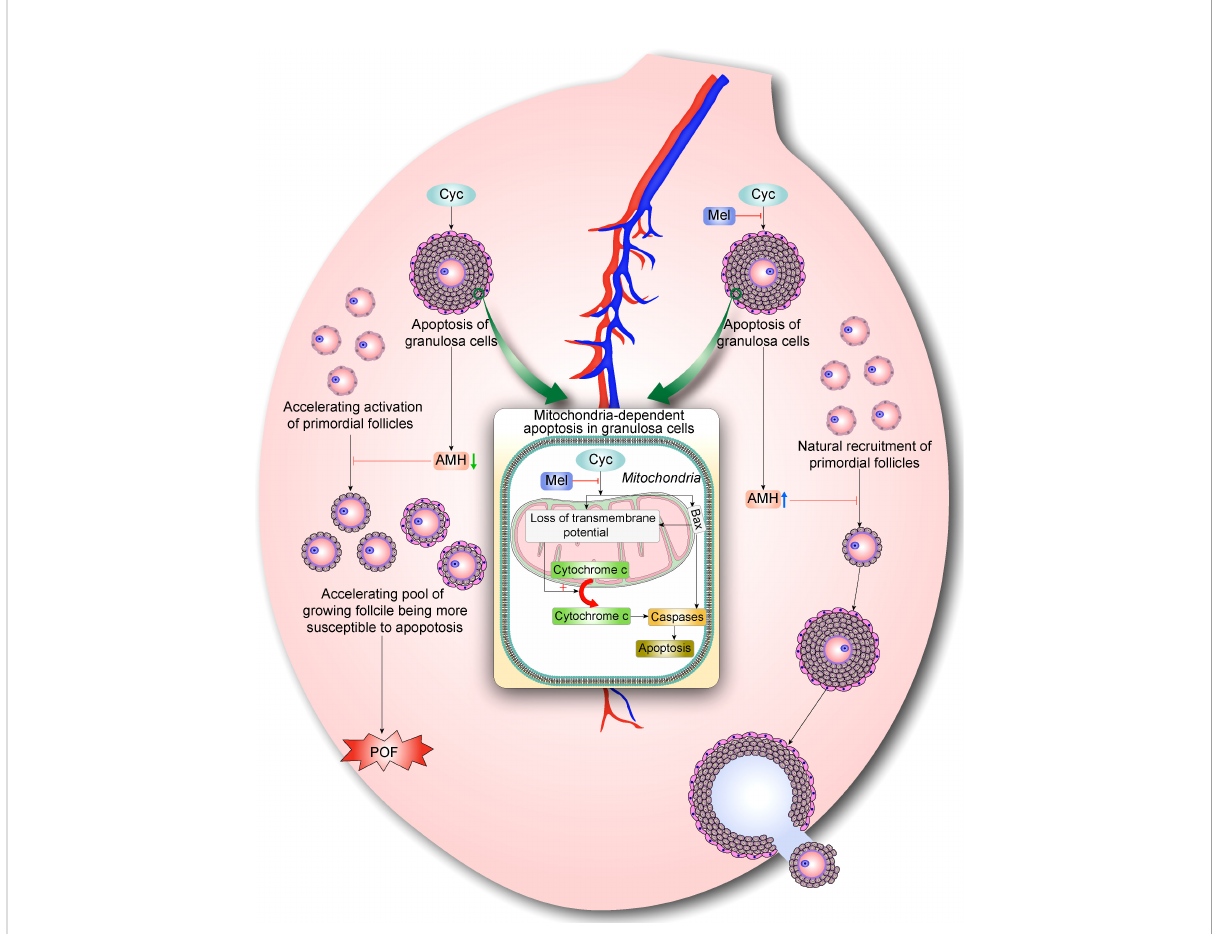
FIGURE 6 Mel prevents Cyc-induced over-activation of primordial follicles through inhibiting ovarian granulosa cell apoptosis and maintaining AMH expression. During normal follicle development, very few primordial follicles are selected and activated, whereas the vast majority of primordial follicles are maintained in a dormant state. AMH is mainly produced by granulosa cells in secondary follicles and early antral follicles. AMH can inhibit the activation of primordial follicles during recruitment and inhibit the sensitivity of antral follicles to FSH during recruitment cycle, thus maintaining AMH levels and selective activation of primordial follicle pool. Cyc exposure disturbs the balance of follicle activation by increasing apoptosis of AMH-secreting granulosa cells in growing follicles, resulting in further decrease of AMH levels and indirect over-activation of primordial follicle pool. Eventually, activated follicles undergo apoptosis and more primordial follicles are stimulated to become activated primary follicles, resulting in POF. With Mel co-treatment, activation of primordial follicles is reduced and apoptosis of AMH-secreting granulosa cells in growing follicles is decreased. Surviving granulosa cells maintained normal levels of AMH production, which regulates natural recruitment of primordial follicles and oogenesis. Hence, Mel restores the balance of follicle activation and returns ovaries to a healthy